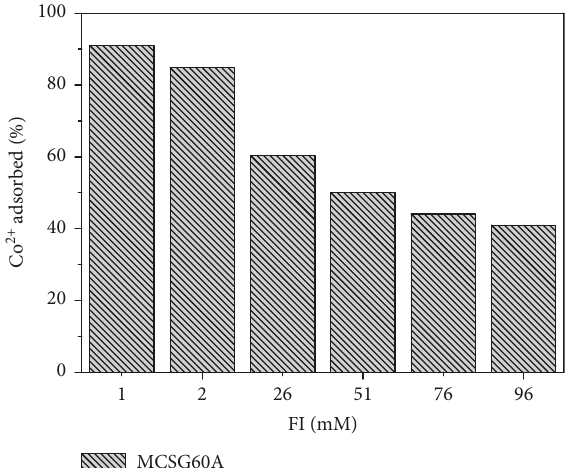
Figure 9: Effect of the ionic strength on cobalt adsorption using MCSG60A [Co 2+ ] 20mg/L, T 25 ° C, adsorbent dosage (cid:30) (cid:30) particle size powder, and (cid:30)